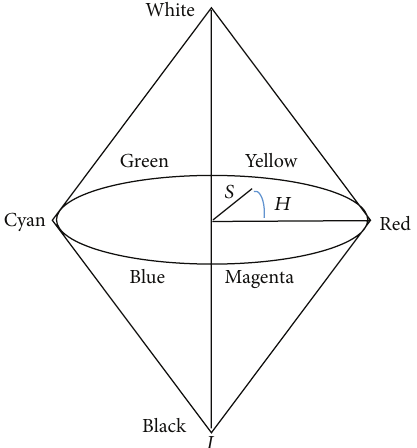
Figure3:HSIcolorspacerepresentedasacirculardoublecone.Hue is the angle from the red axis, saturation is the distance from the intensity axis, and intensity is the position on the vertical axis.